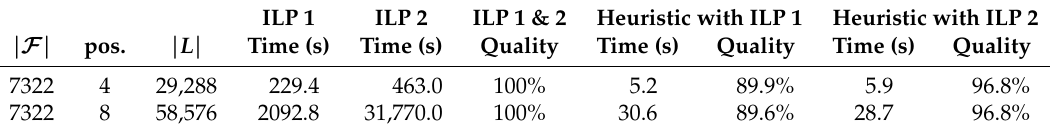
Table 5. Experimental results for the data set of 7322 places from the Internet. The first row refers to experiments with the four-position model; for the second row, the eight-position model was used. ILP 1 ILP 2 ILP 1 & 2 Heuristic with ILP